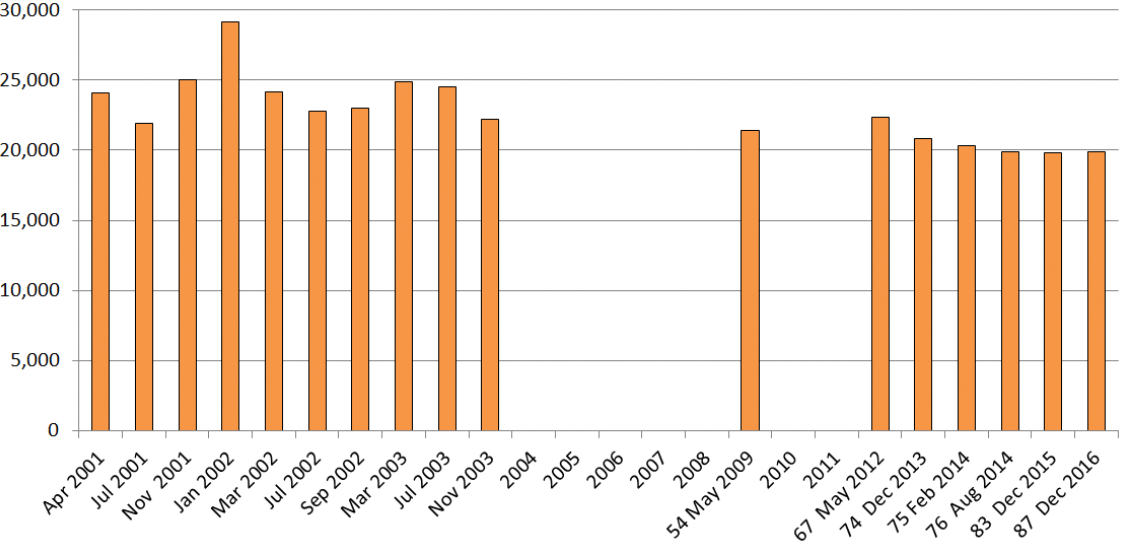
Figure 1. Protein counts from the Ensembl pipeline database releases over the first three years and last seven years. The latter are only those from the current archive that have protein rebuilds rather than maintenance/patch releases with nearly identical